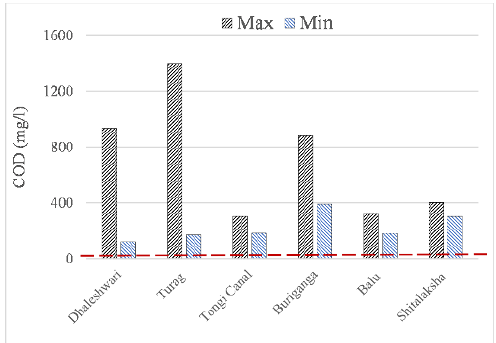
Figure 8 . Max m vs. Min m Concentration of COD for the peripheral rivers of Dhaka for with WHO standards (10 mg/L).